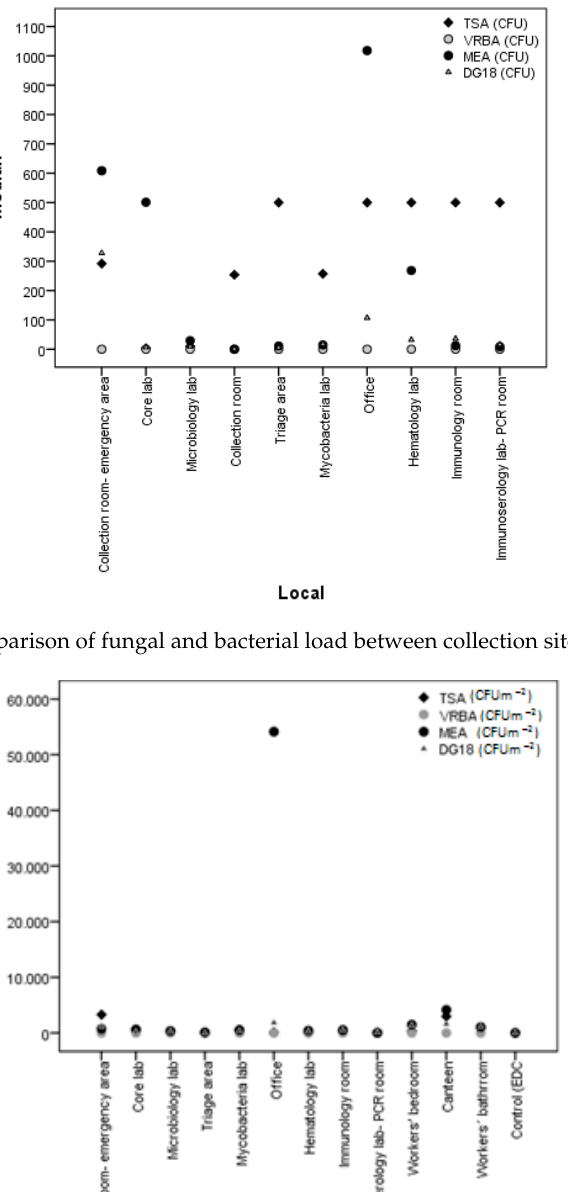
Figure 2. Cumulative microbial contamination (TSA, VRBA, MEA, and DG18) and cell viability (average percentage of extinction, MTT assay) in EDC samples. (+), low cytotoxic effect; (++), medium cytotoxic effect.